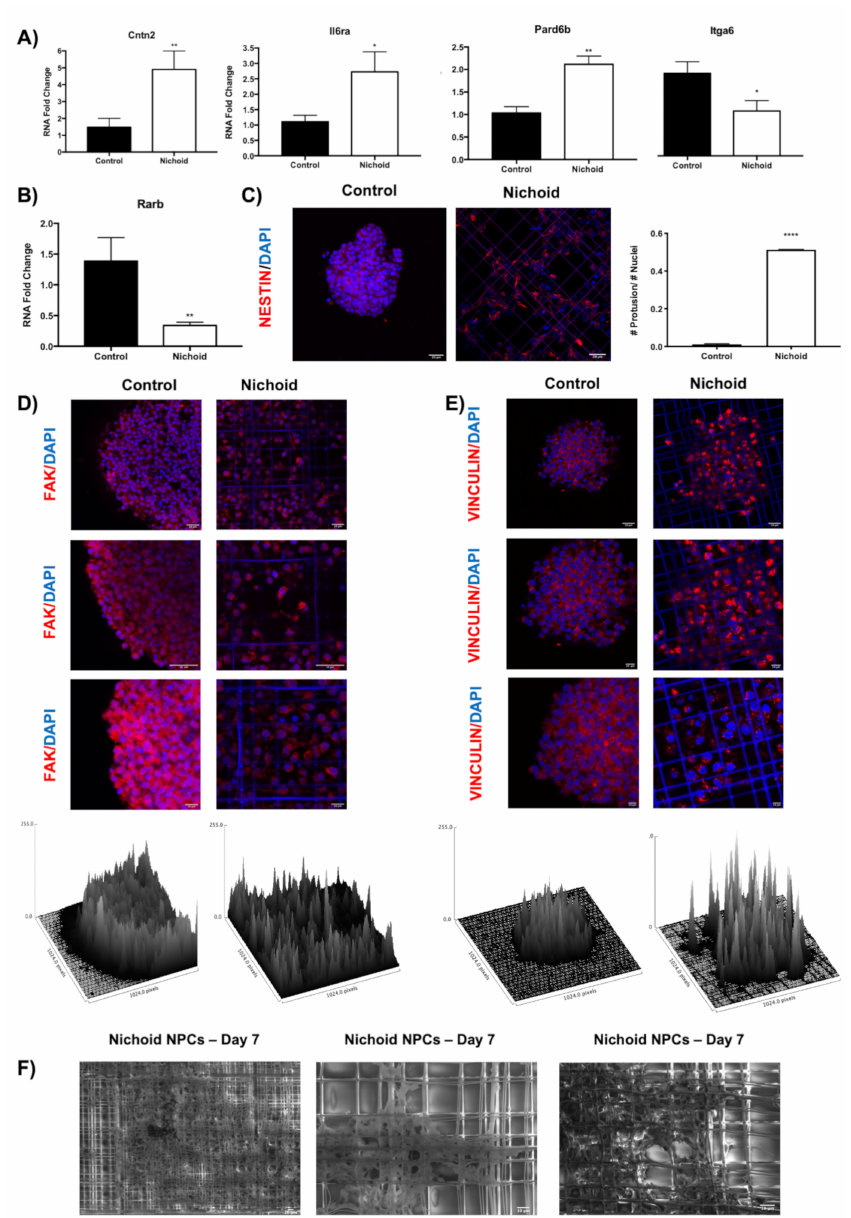
Figure 6. Evidences of adhesion complexes and cytoskeletal deregulation. ( A ) Di ff erential expression of genes involved in adhesion complexes was verified by real-time PCR in a larger cohort (four experiments each performed in duplicates, N = 8) of NPCs grown in standard floating conditions and NPCs grown inside the Nichoid for Cntn2, Il6ra, Pard6b, and Itga6. GAPDH was used as housekeeping gene. Data are expressed as mean of four independent experiments, each performed in duplicate ± SEM ( n = 8), * p < 0.05, ** p < 0.01 vs. control. ( B ) Di ff erential expression of genes involved in cytoskeletal remodeling was verified by real-time PCR in a larger cohort (four experiments each performed in duplicates, N = 8) of NPCs grown in standard floating conditions and NPCs grown inside the Nichoid for Rarb. GAPDH was used as housekeeping gene. Data are expressed as mean of four independent experiments, each performed in duplicate ± SEM (n = 8), ** p < 0.01, vs. control. ( C ) Immunofluorescence images of Nestin, in red, and nuclei, in blue (DAPI), of standard floating NPCs or inside the Nichoid. Scale bar: 20 µ m. Images are representative of two fields acquired per Nichoid (N = 2). The histogram refers to the number of prolongments counted in the image over the total nuclei number (N = 2, **** p < 0.0001 vs. control). ( D ) Immunofluorescence images of focal adhesion kinase (FAK), in red, and nuclei, in blue (DAPI), of standard floating NPCs or inside the Nichoid. Scale